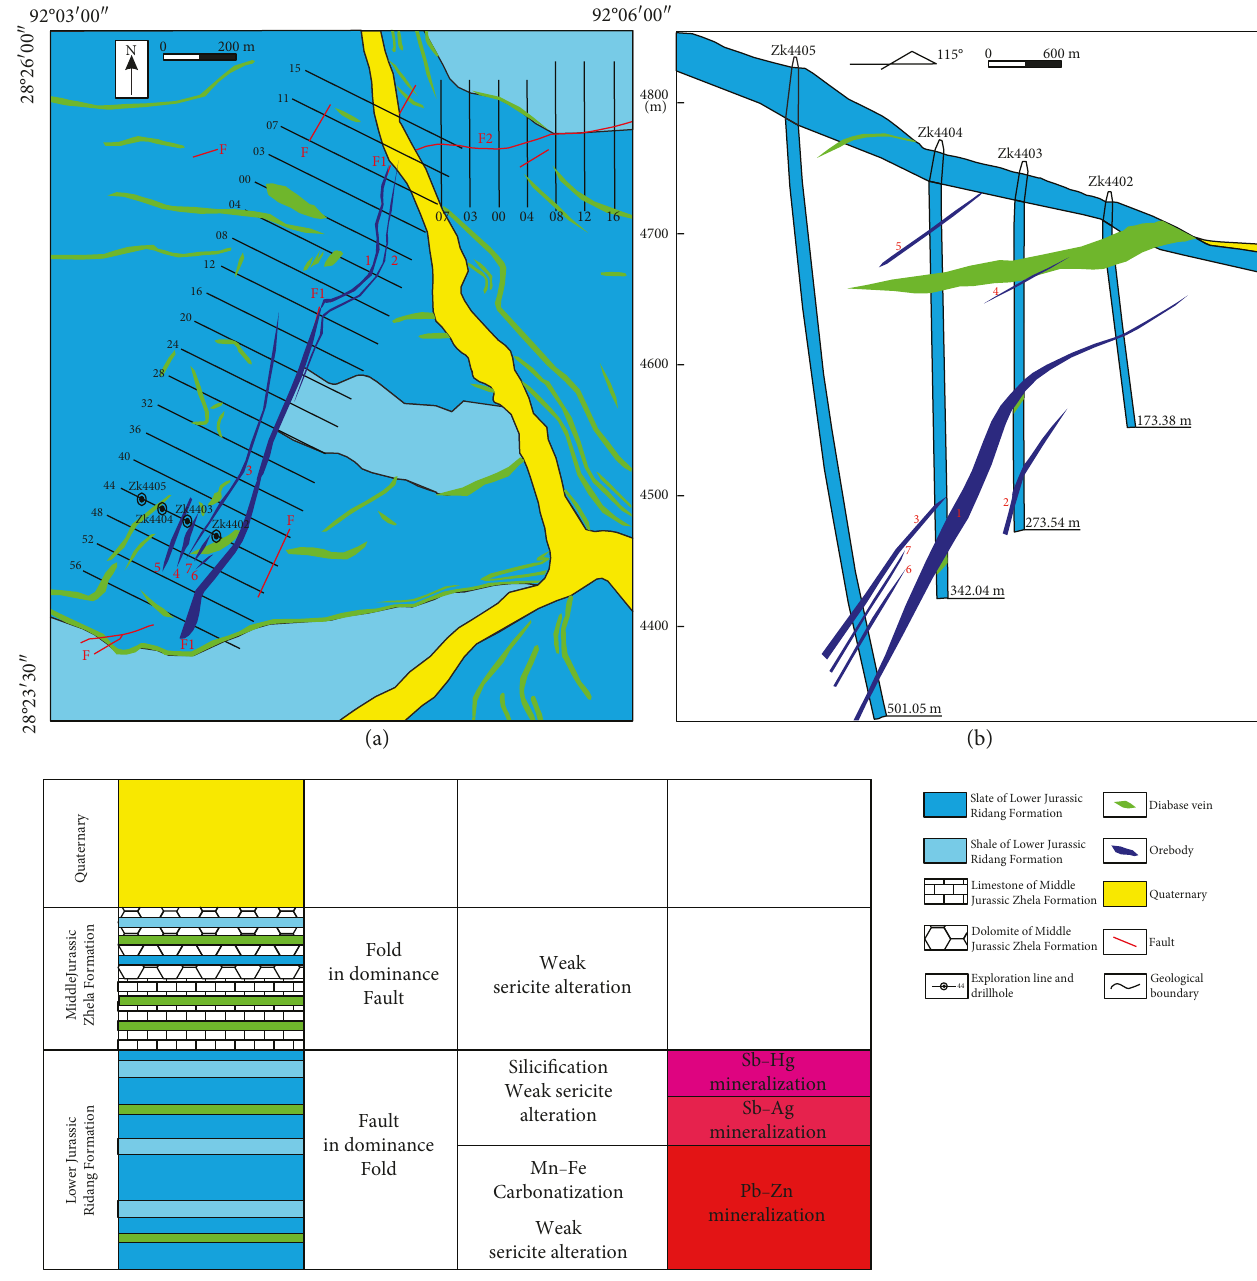
Figure 2: (a) Geological map of the Keyue Sb – Pb – Zn – Ag deposit (modi fi ed from Yang [10]); (b) cross-section along Exploration Line 44; (c) the schematic illustration of the internal structure of the Keyue deposits, with the vertical zonation, di ff erent alteration associations, and